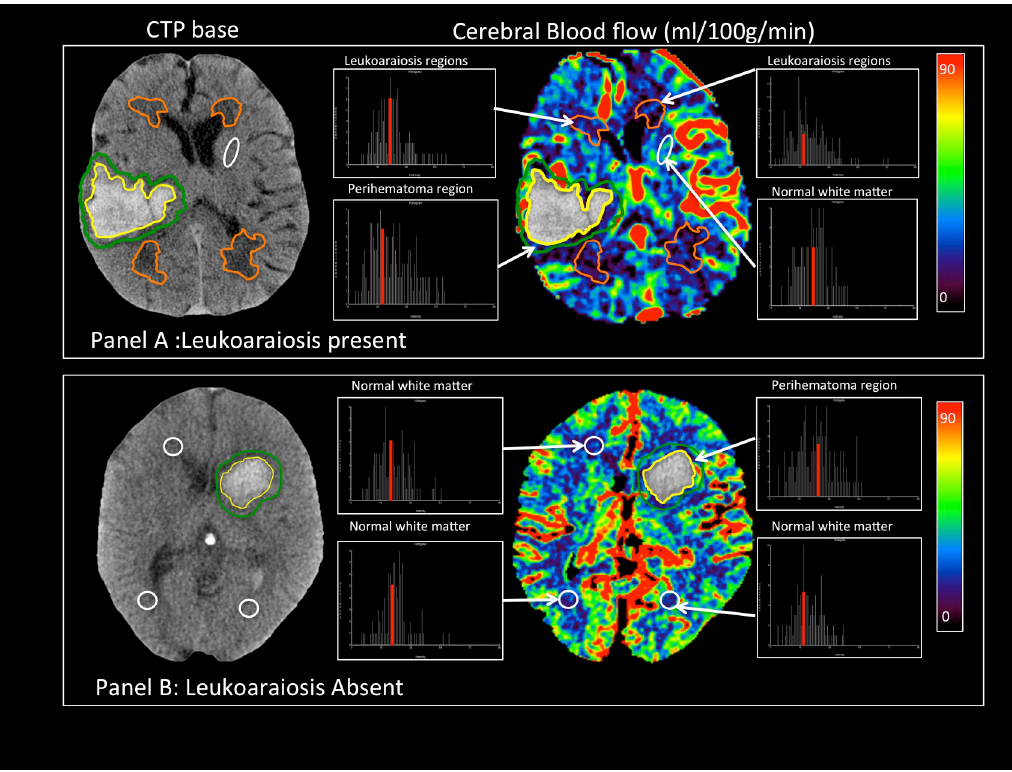
Fig 1. Measurement of perfusion parameters in patients with leukoaraiosis (A) and without leukoaraiosis (B). A: Regions- of-interest in the perihematoma region (green), leukoaraiosis tissue (orange) and normal white matter (white). B: Region-of- interest object maps were drawn Perihematoma region (green), normal white matter (white). The histograms in demonstrate the distribution of the absolute cerebral perfusion values in the object maps.